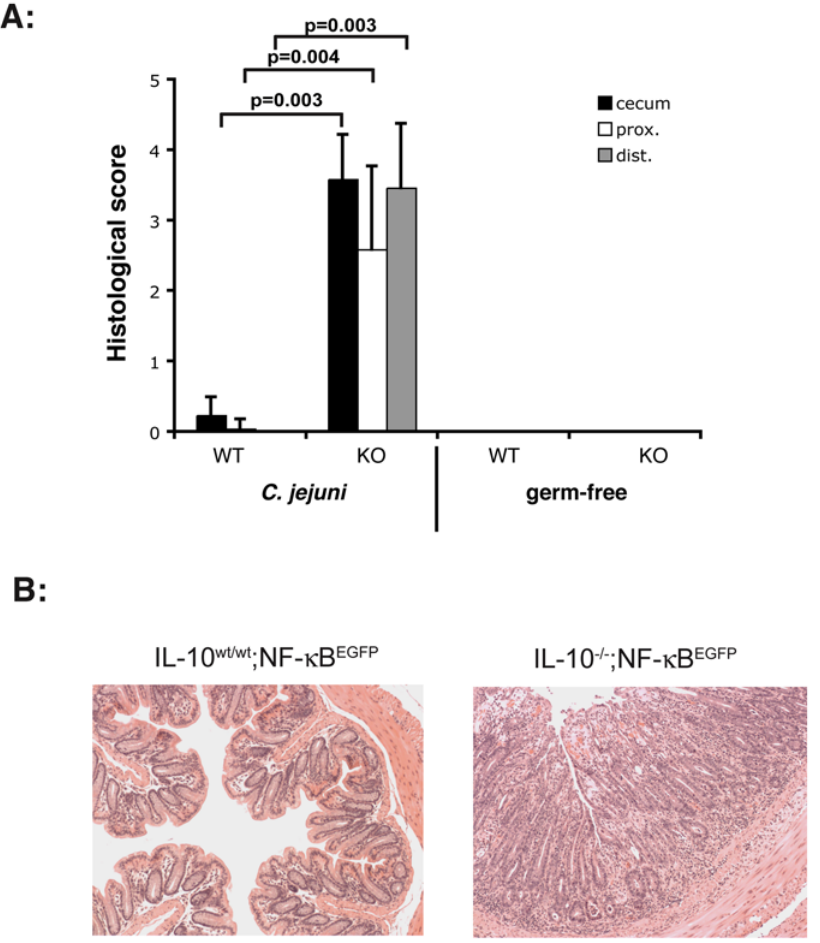
Figure 4. Histology showed strong signs of inflammation in IL-10 2 / 2 ; NF- k B EGFP mice. Gnotobiotic IL-10 2 / 2 ; NF- k B EGFP mice were associated with C. jejuni by oral gavage (10 8 cfu/mouse) for 14 days. Mice were euthanized and different parts of the colon were paraffin-embedded and used for H&E staining. Histological analysis of C. jejuni -associated IL-10 2 / 2 ; NF- k B EGFP and IL-10 wt/wt ; NF- k B EGFP was performed as described in Materials and Methods. Histological score revealed statistical significant difference between IL-10 wt/wt ; NF- k B EGFP and IL-10 2 / 2 ; NF- k B EGFP associated with C. jejuni (cecum *p=0.003, prox *p=0.004, dist *p=0.003). IL-10 wt/wt ; NF- k B EGFP : n=8, IL-10 2 / 2 ; NF- k B EGFP : n=4, IL-10 wt/wt ; NF- k B EGFP C. jejuni associated: n=13, IL-10 2 / 2 ; NF- k B EGFP C. jejuni associated: n=12. WT=IL-10 wt/wt ; NF- k B EGFP , KO=IL-10 2 / 2 ; NF- k B EGFP